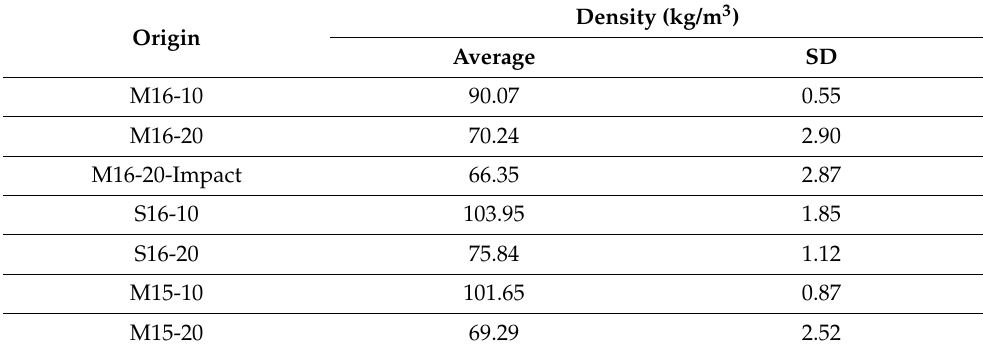
Table 4. Bulk density of rapeseed straws.